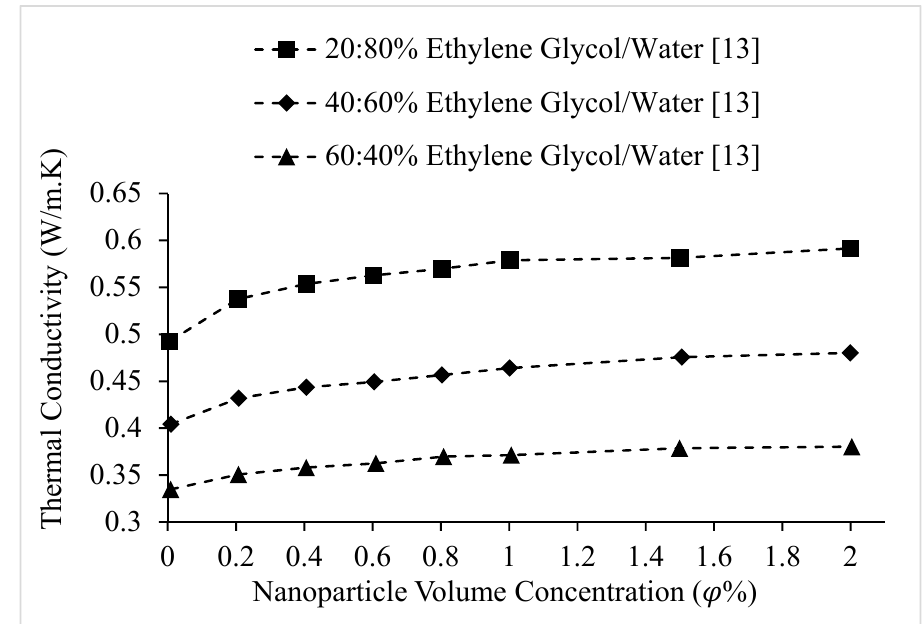
Figure 13. Variation of Fe 3 O 4 nanofluid thermal conductivity as a function of nanoparticle volume fraction, 𝜑, for different weight concentrations of Ethylene Glycol/water base liquid, at 20 °C.